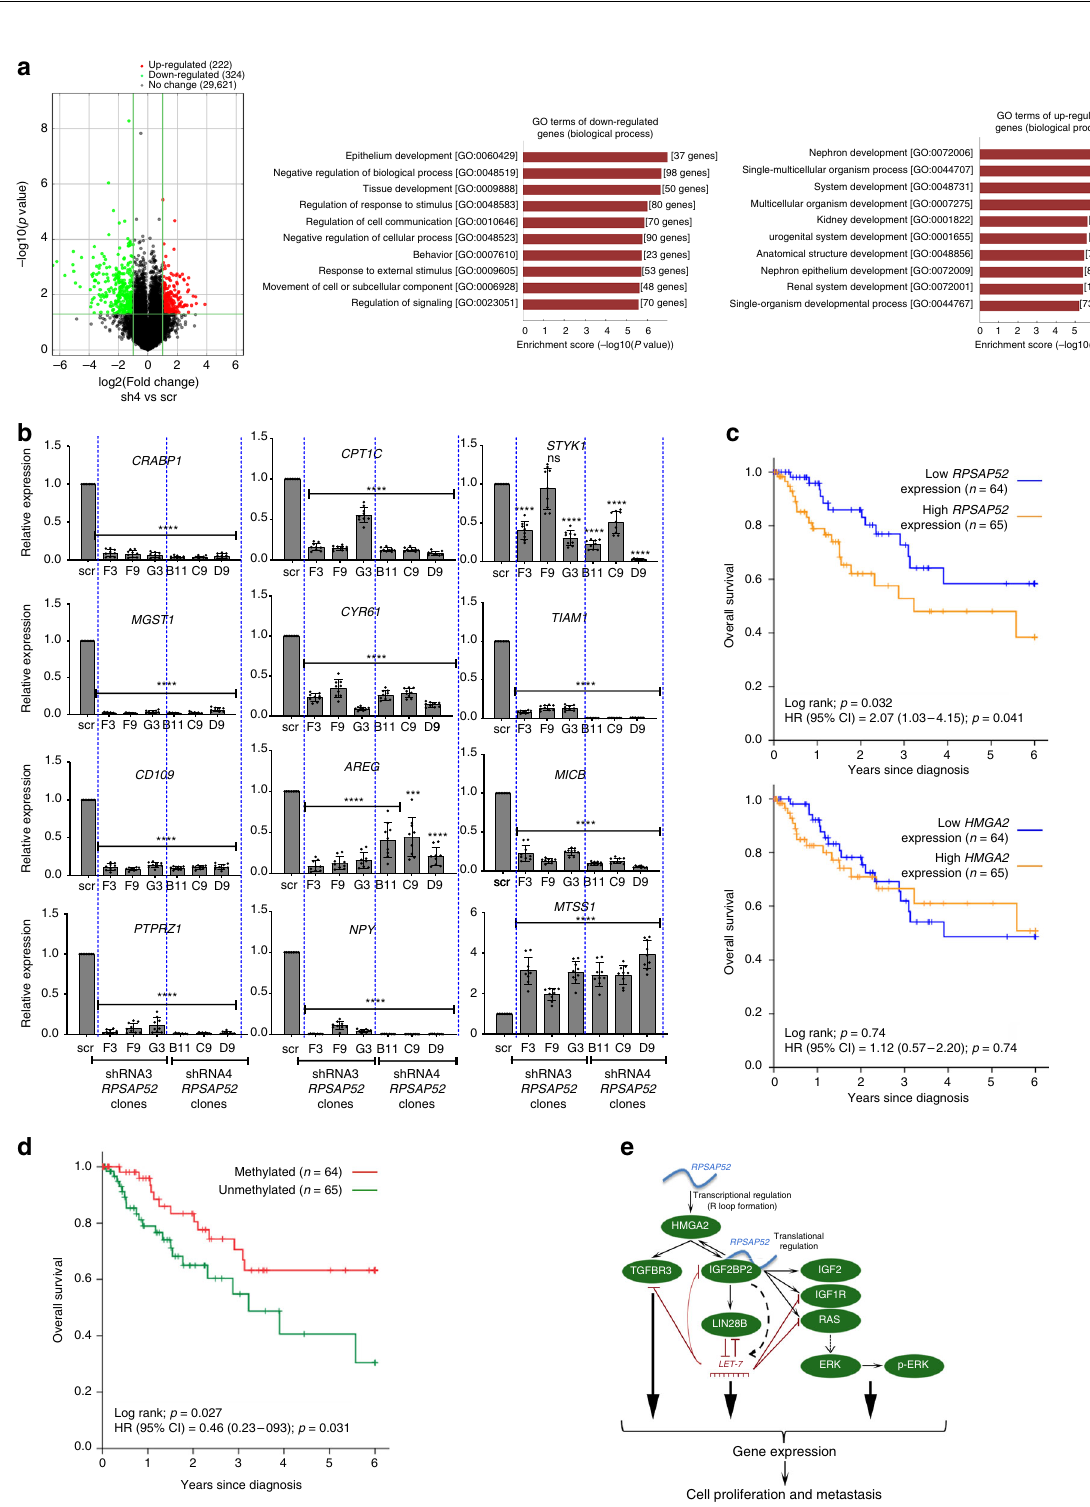
Bisul fi te genomic sequencing . The Methyl Primer Express v1.0 software (Applied Biosystems) was used to design speci fi c primers for the methylation analysis of HMGA2/RPSAP52 island (Supplementary Table 1). Genomic DNA (1 µg) was subjected to sodium bisul fi te treatment using the EZ DNA Methylation-Gold kit (Zymo Research). For bisul fi te genomic sequencing, 300 – 500 bp fragments were ampli fi ed using 1 – 2 μ l of bisul fi te-converted DNA with Immolase Taq polymerase (Bioline) for 42 cycles. The resulting PCR products were gel-puri fi ed with NucleoSpin ® Gel and PCR Clean-up (Macherey-Nagel) and then cloned into the pSpark ® TA vector (Canvas) according to the manufacturer ’ s protocol. For all samples, 10 colonies were NATURE COMMUNICATIONS| (2019) 10:3979